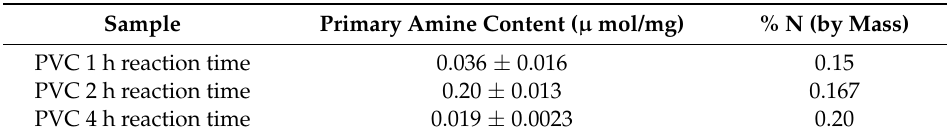
Figure 6. Total nitric oxide release from SNAP-PVC polymer synthesized with different reaction times for initial amination. Chemiluminescence detection was used to record total NO release triggered with UV light. The SNAP-PVC were reacted with ethylenediamine for 1 h (blue), 2 h (green), and 4 h (red). The measurements were made with cast films of SNAP-PVC that were allowed to cure under ambient conditions protected from light. Table 1. Primary amine content using the ATTO-TAG FQ Amine-Derivitization test and nitrogen content via CHN analysis of PVC aminated for 1, 2 and 4 h to observe the primary amine and nitrogen content as reaction time with ethylenediamine increases.